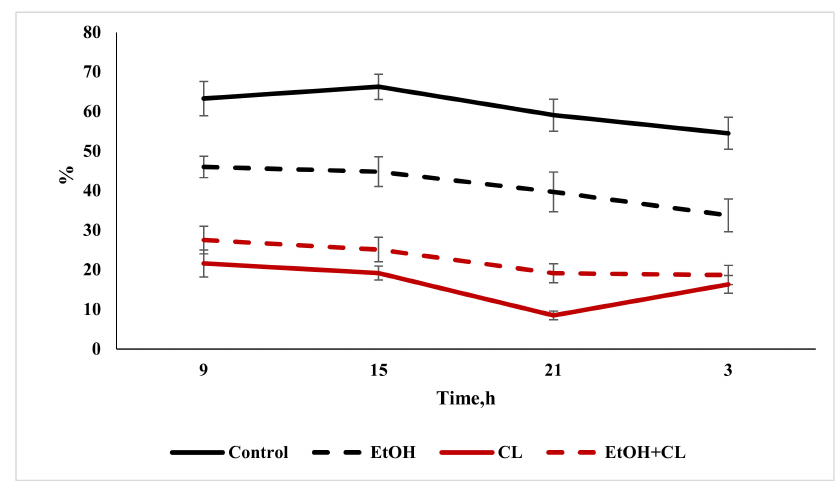
Figure 19. Daily fluctuations in the expression of Bmal1 in rat